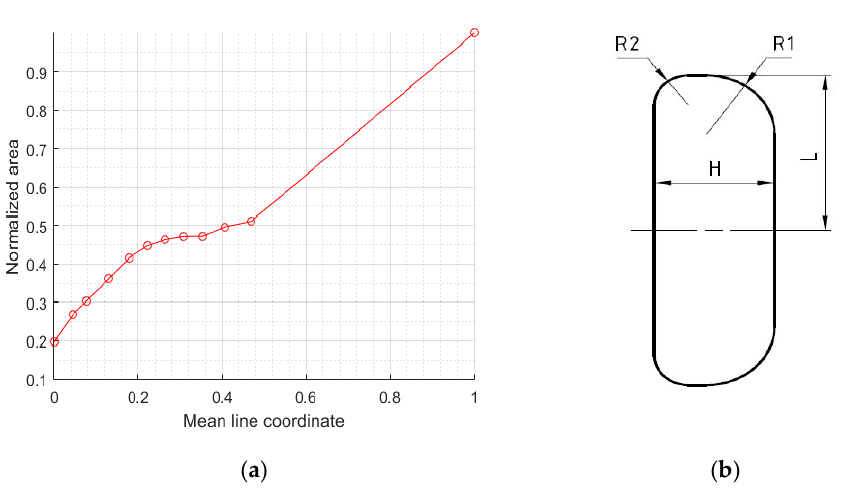
Figure 5. Draft tube geometry definition: ( a ) area distribution; ( b ) shape of a generic cross section.